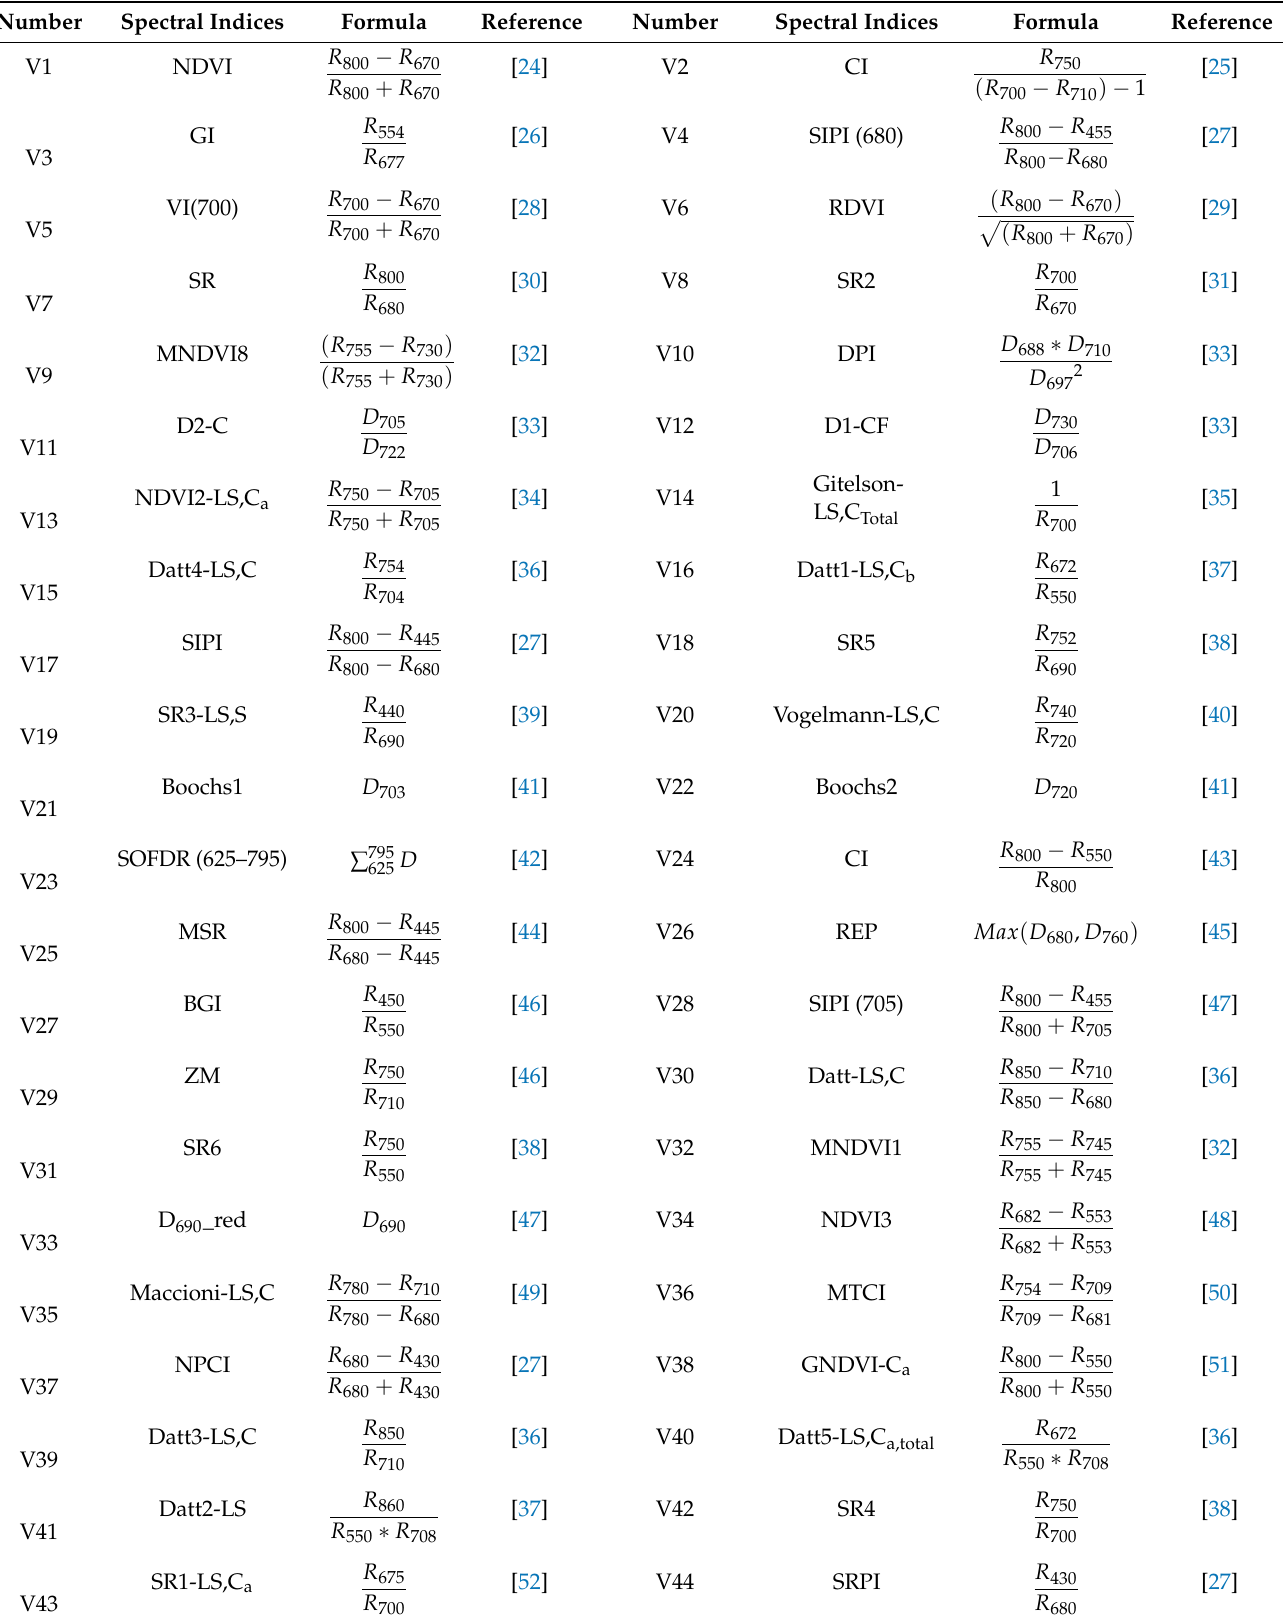
Table 2. Spectral indices used to estimate the vegetation physiological and ecological